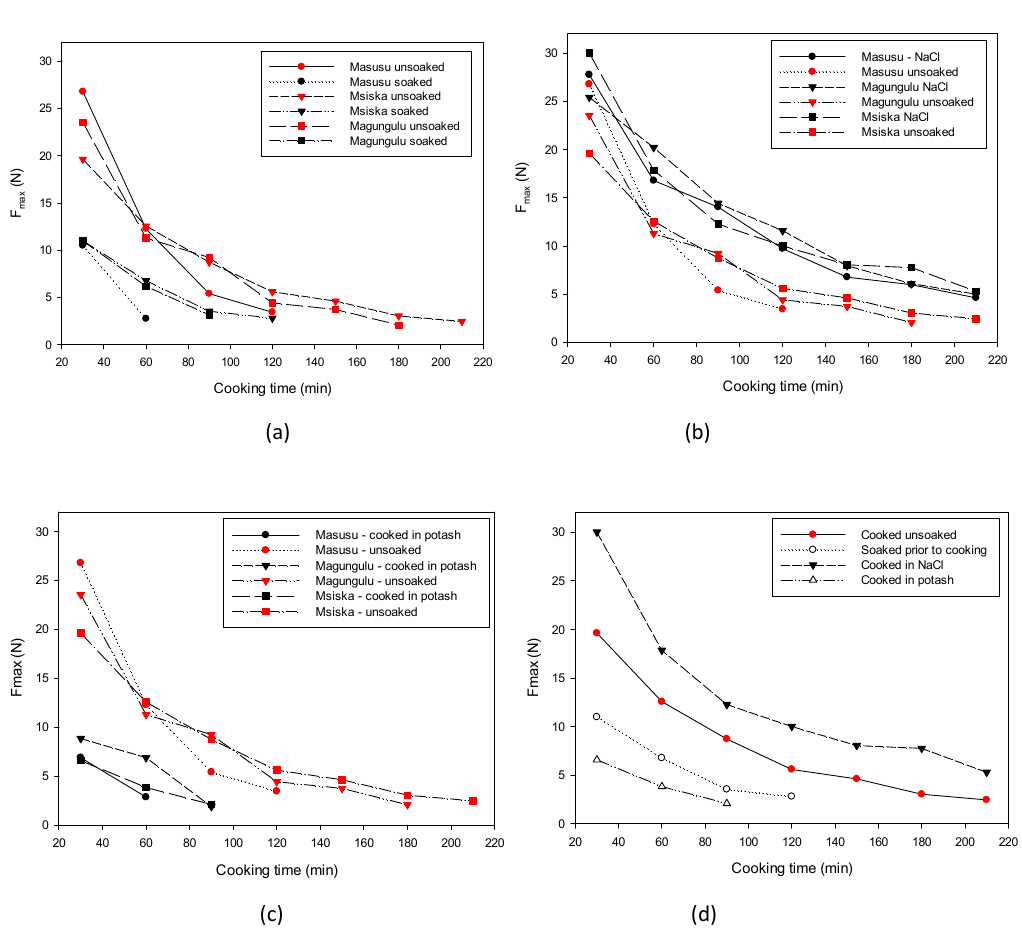
Figure 5. Effect of softening techniques on common beans cookability profile: ( a ) soaking before cooking, ( b ) cooking in NaCl solution, ( c ) cooking in potash solution, and ( d ) comparison of softening techniques for HTC cultivar (Msiska).